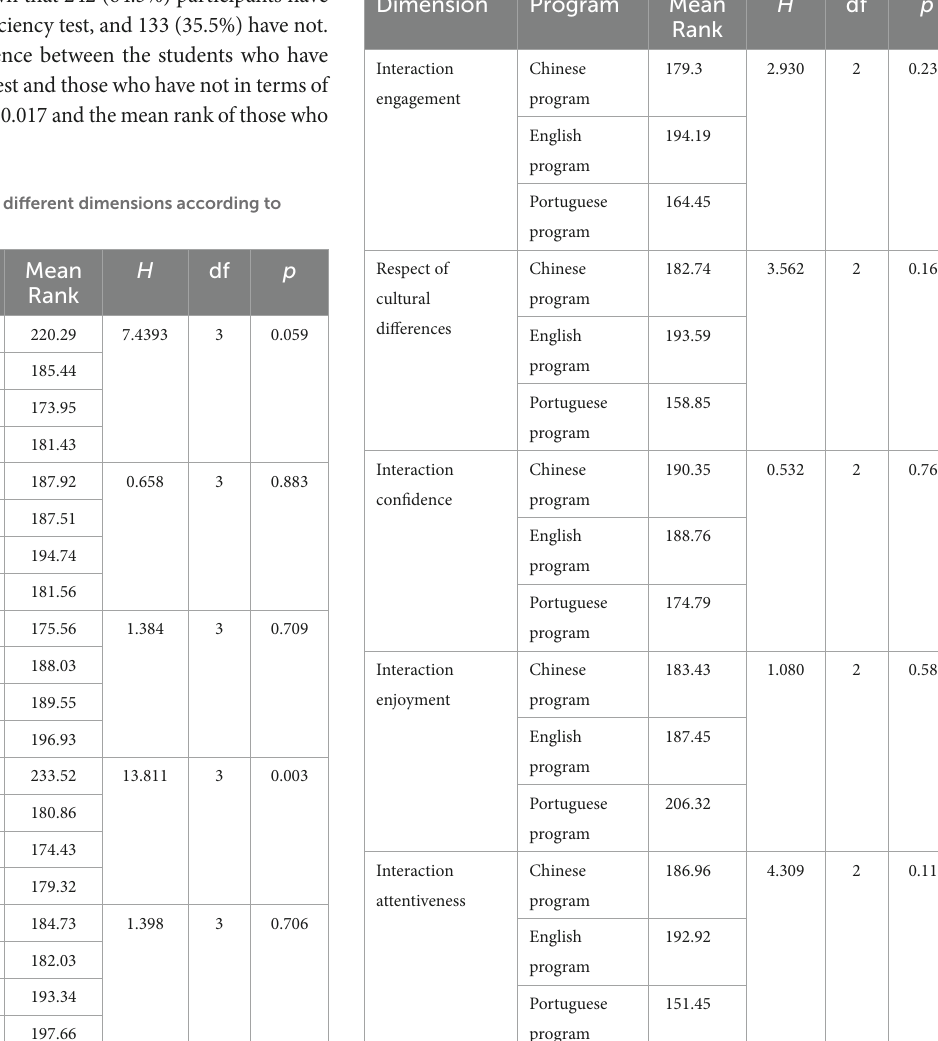
TABLE 7 Kruskal-Wallis H test for different dimensions according to program (language of instruction adopted in one’s major).